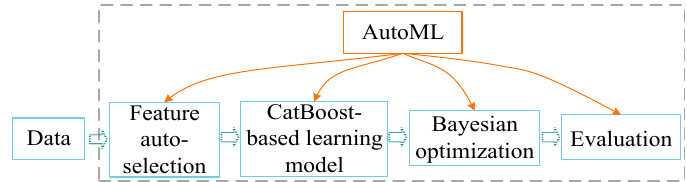
Figure 1. The scheme of AutoML in TSA.